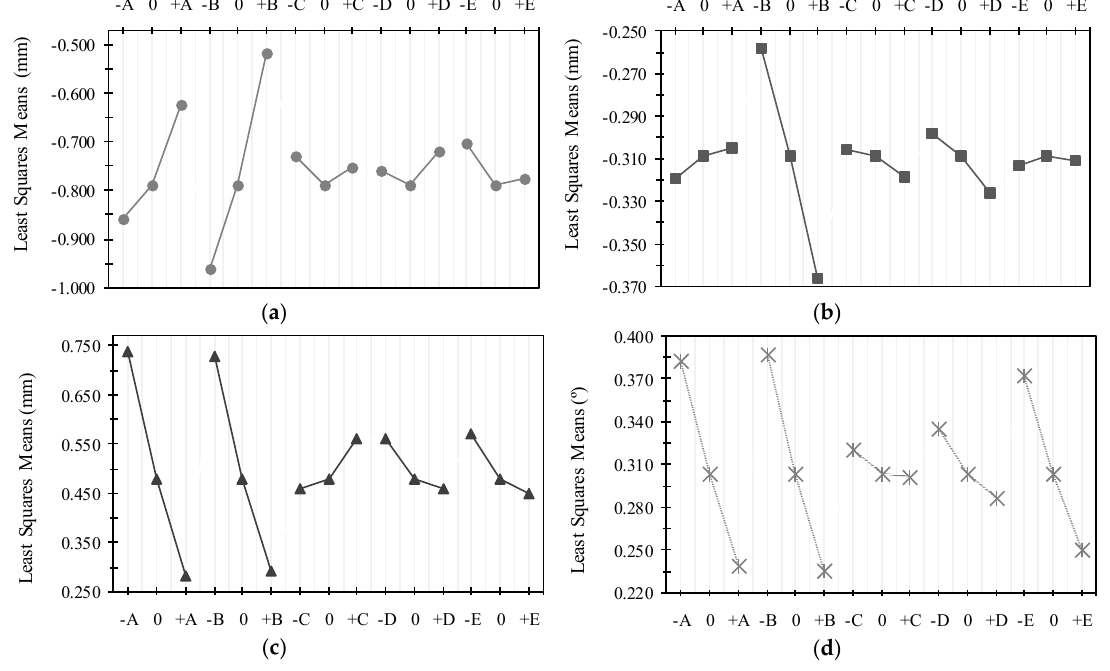
Figure 3. Main experiment: ( a ) DEV 01 vs. variations of factor levels; ( b ) DEV 02 vs. variations of factor levels; ( c ) DEV 03 vs. variations of factor levels; and( d ) DEV 04 vs. variations of factor levels.